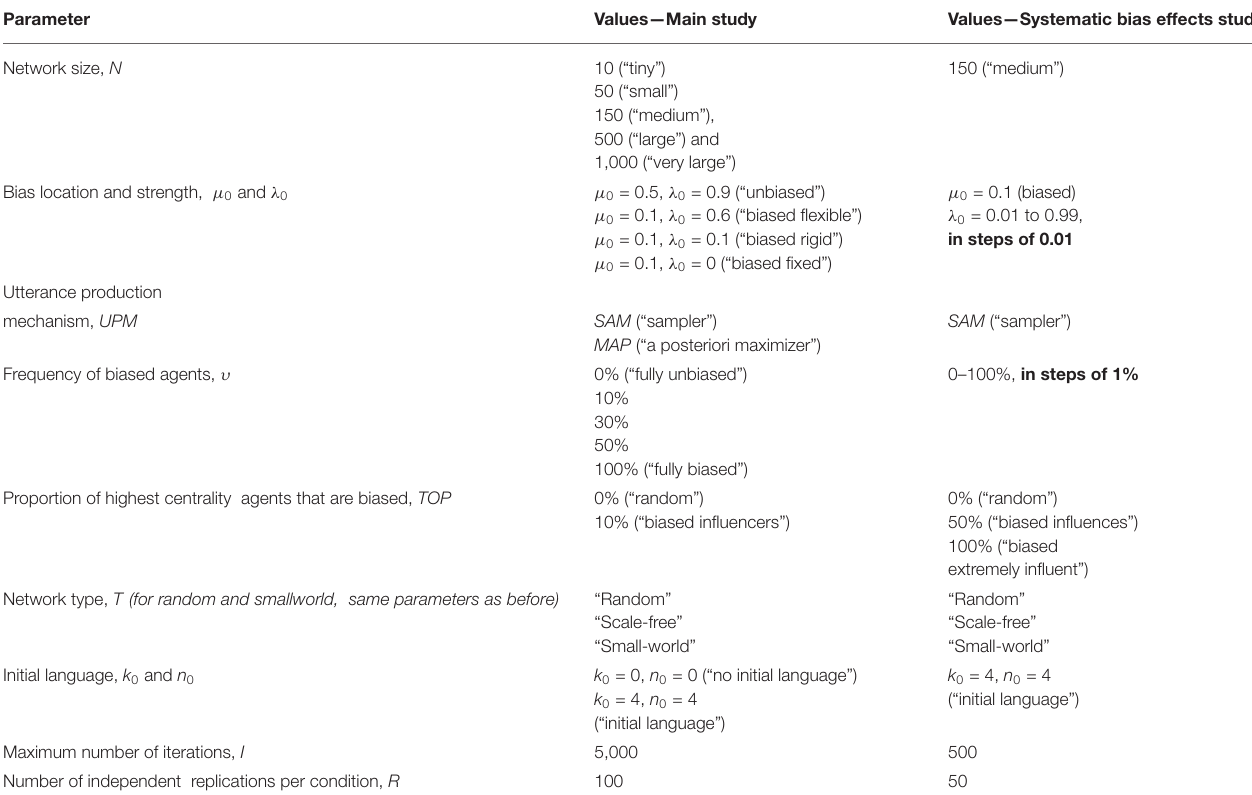
TABLE 2 | Values used in our